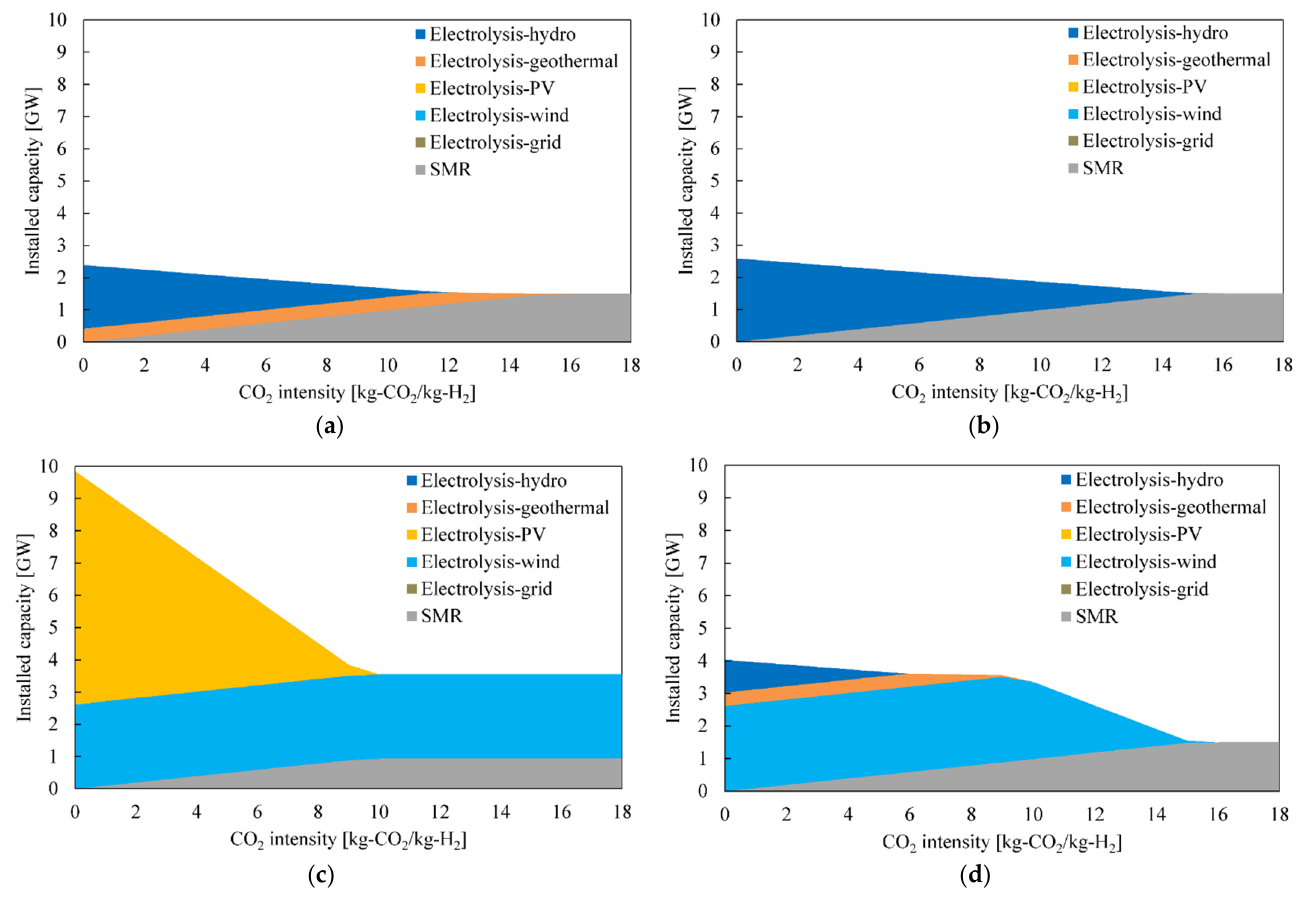
Figure 4. Installed capacity as function of the CO 2 intensity for hydrogen production on a cradle-to- gate basis. ( a ) Low-Cost scenario; ( b ) Low Energy Use scenario; ( c ) Water-Energy-Carbon scenario; ( d ) Water-Energy-Carbon-Cost scenario.